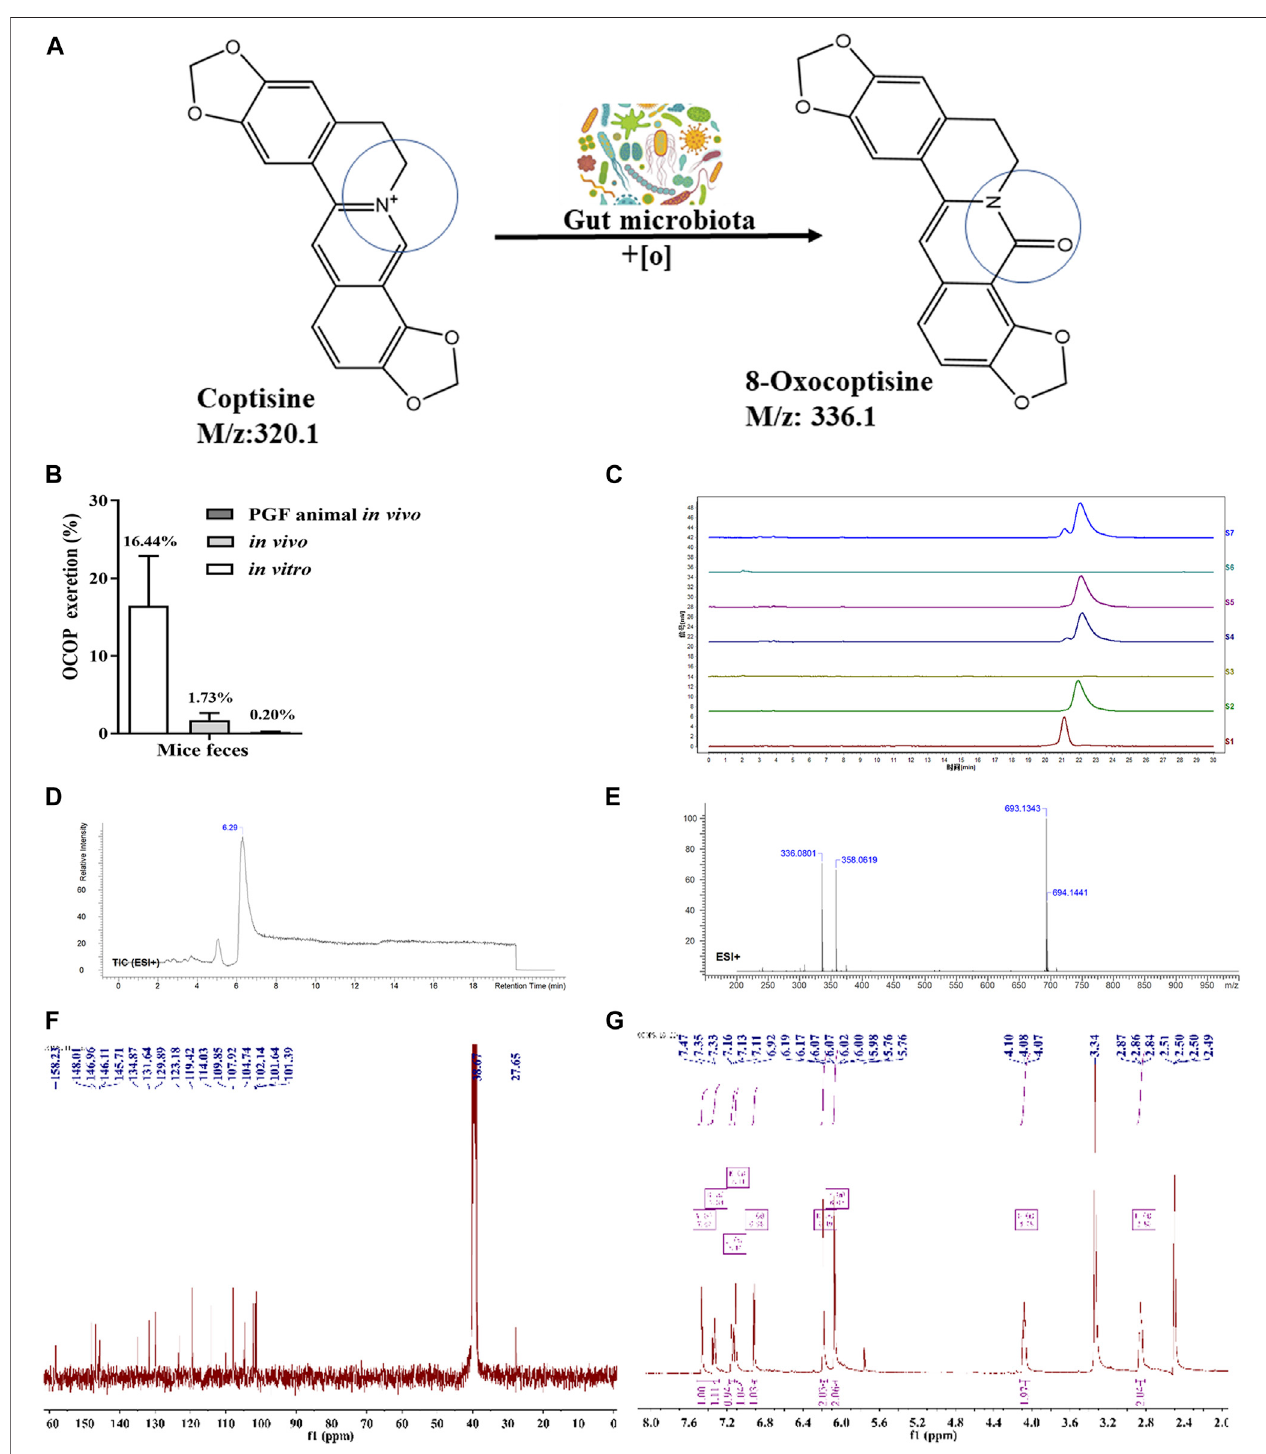
FIGURE 1 | Generation of OCOP by gut microbiota (A) COP was metabolized into OCOP by gut microbiota (B) The OCOP content (%) in the mice feces after administration invitro and invivo for24 h (C) HPLCanalysisofS1(standardsolutionofOCOP),S2(standardsolutionofCOP),S3(thefecesofnormalmice),S4(thefeces ofmice orallytreatedwith100 μ g/ml COP), S5(the fecesofpseudo-germfreemice orallytreated with100 μ g/ml COP), S6(thefeces ofnormalmice invitro ),and S7(the feces of normal mice incubated with 100 μ g/ml COP in vitro ) (D and E) ESI + -MS 1 spectrum of OCOP in methanol (F and G) 1 H NMR, 13 C-NMR spectrum data of